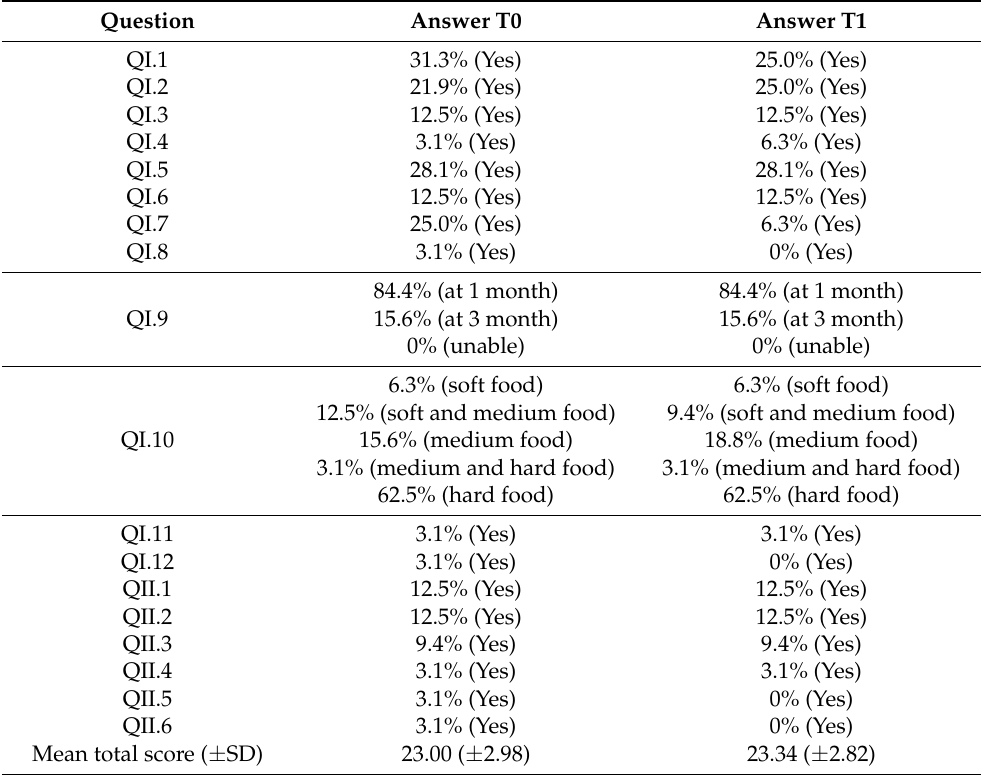
Table 4. Response to questionnaire (19 items) at T0 and